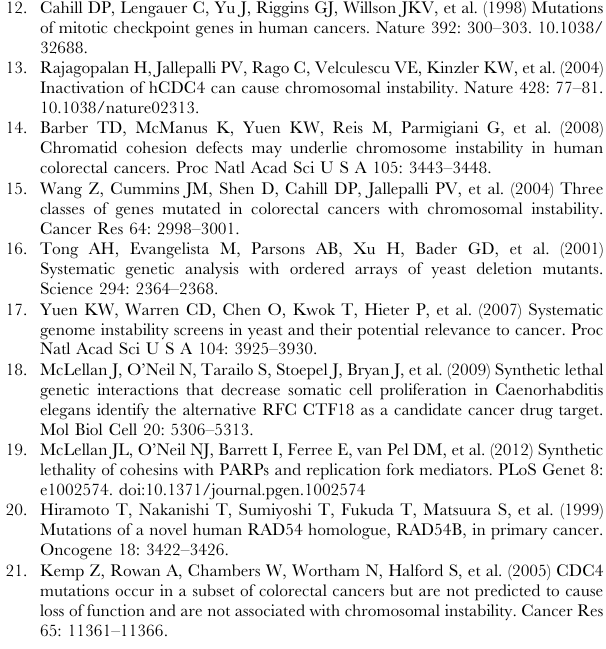
Table S2 siRNA pool silencing in hTERT cells. Table S3 Synthetic Lethality between FEN1 and cancer genes in hTERT cells. Horizontal lines indicate experiments carried out on different days. Table S4 Antibodies employed in Western blots in this study. Table S5 Genetic interactors of rad27 D and cancer mutations. Table S6 Raw data from rad27 D SGA against a collection temperature-sensitive and DAmP alleles of essential